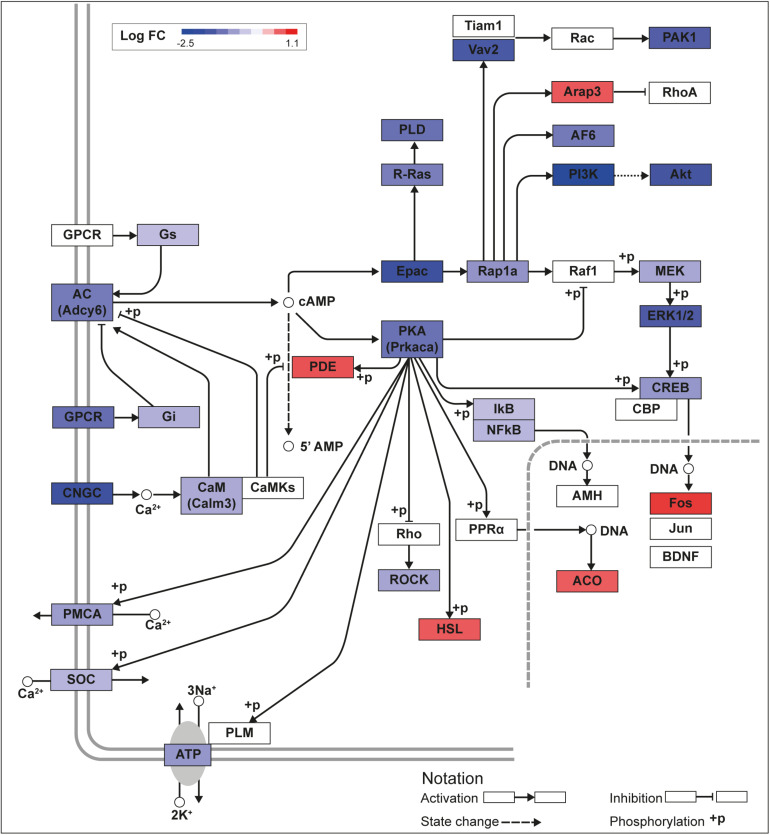
KLF13 regulates cAMP signaling pathway genes in HT22 cells. We previously conducted an RNA sequencing analysis in the HT22-TR/TO-V5Klf13-1 cell line treated with or without doxycycline for 8 h to induce the V5Klf13 transgene (Ávila-Mendoza et al., 2020). We analyzed differentially regulated genes in the context of the Kyoto Encyclopedia Genes and Genomes signaling pathways. Shown is the core of the cAMP signaling pathway (KEGG:04024) overlayed with differential gene expression values for each gene with a p-value < 0.05. The color of the box for each gene represents the direction of change in mRNA levels (Log fold change – Log FC shown in the legend); i.e., boxes with dark blue indicate the largest decreases, while boxes with dark red indicate the largest increases in mRNA levels.